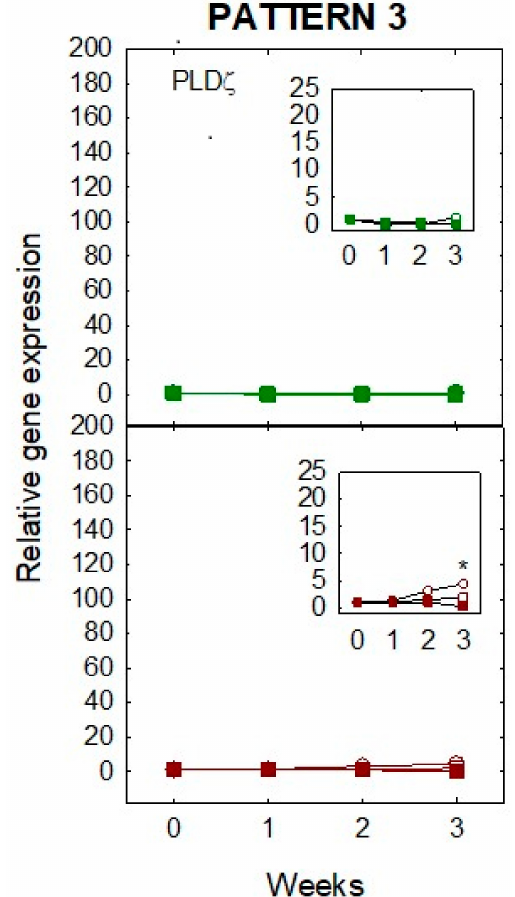
Figure 6. E ff ect on relative gene expression of di ff erent conditions of water stress (severe drought (0% ET, O), mild drought (50% ET, (cid:3) ), and fully watered plants (100% ET, (cid:4) )) in leaves (upper panel) and roots (lower panel) of ‘Pineapple’ sweet orange trees during a 3-week period. Pattern 3: Expression of CsPLD ζ . Inset panels show magnified scale to appreciate di ff erences. Data are means ± SE of three biological replicates. Asterisks indicate significant di ff erences at * p < 0.05.